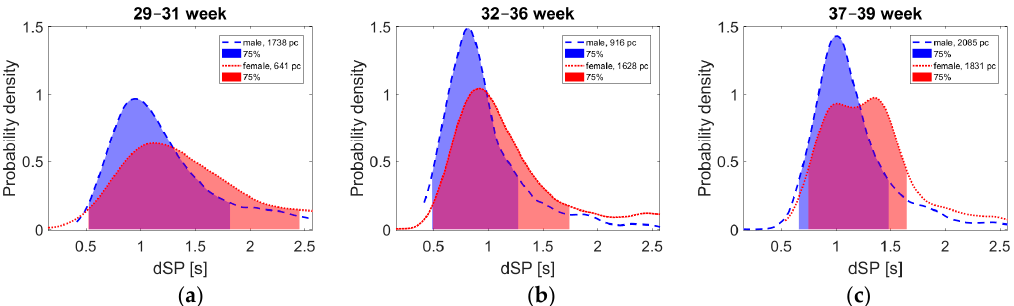
Figure 4. The probability densities of dSP time intervals according to the different gestational ages (see a – c ) and the sex (blue marks the males and red marks the females). At the beginning of the third trimester, there are still many more uncertain FBM episodes than later during the pregnancy.